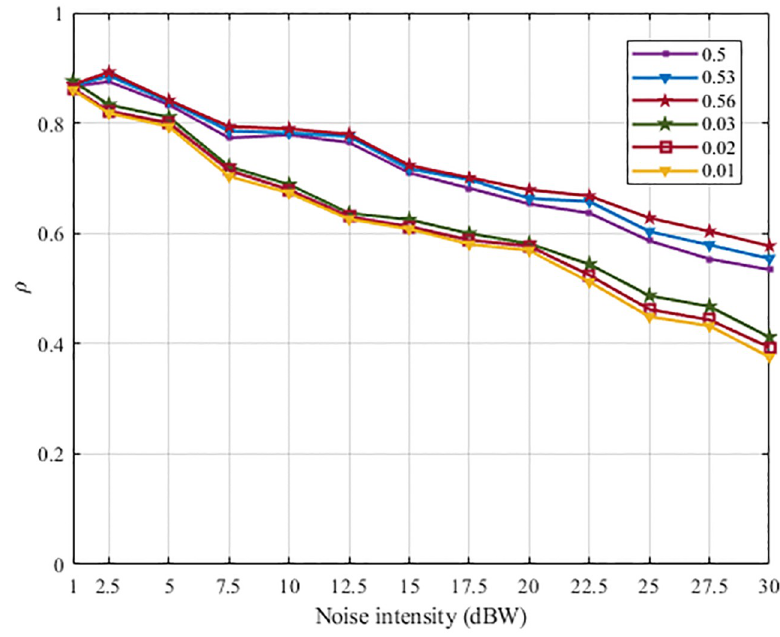
Fig 11. The change of the ρ of the three SFSNNs with the high ACC and the three SFSNNs with the low ACC.